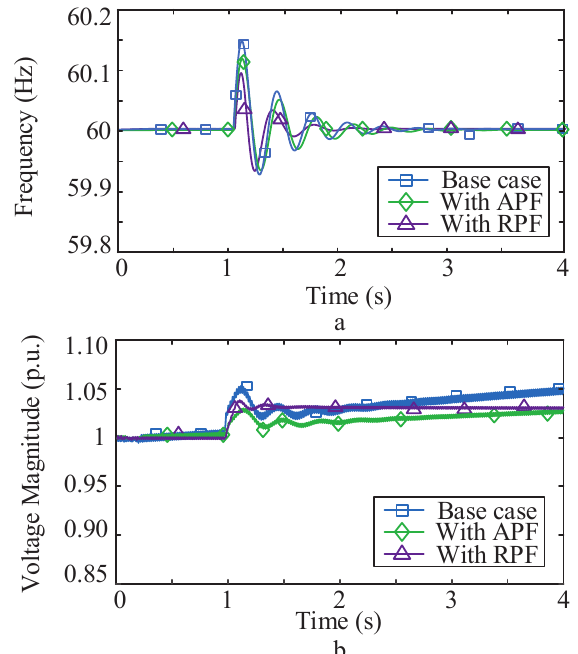
Figure 12. Ride-through capability enhancement of synchronous DG using the proposed scheme during loss of one of the parallel line ( a ) Frequency ( b ) Voltage